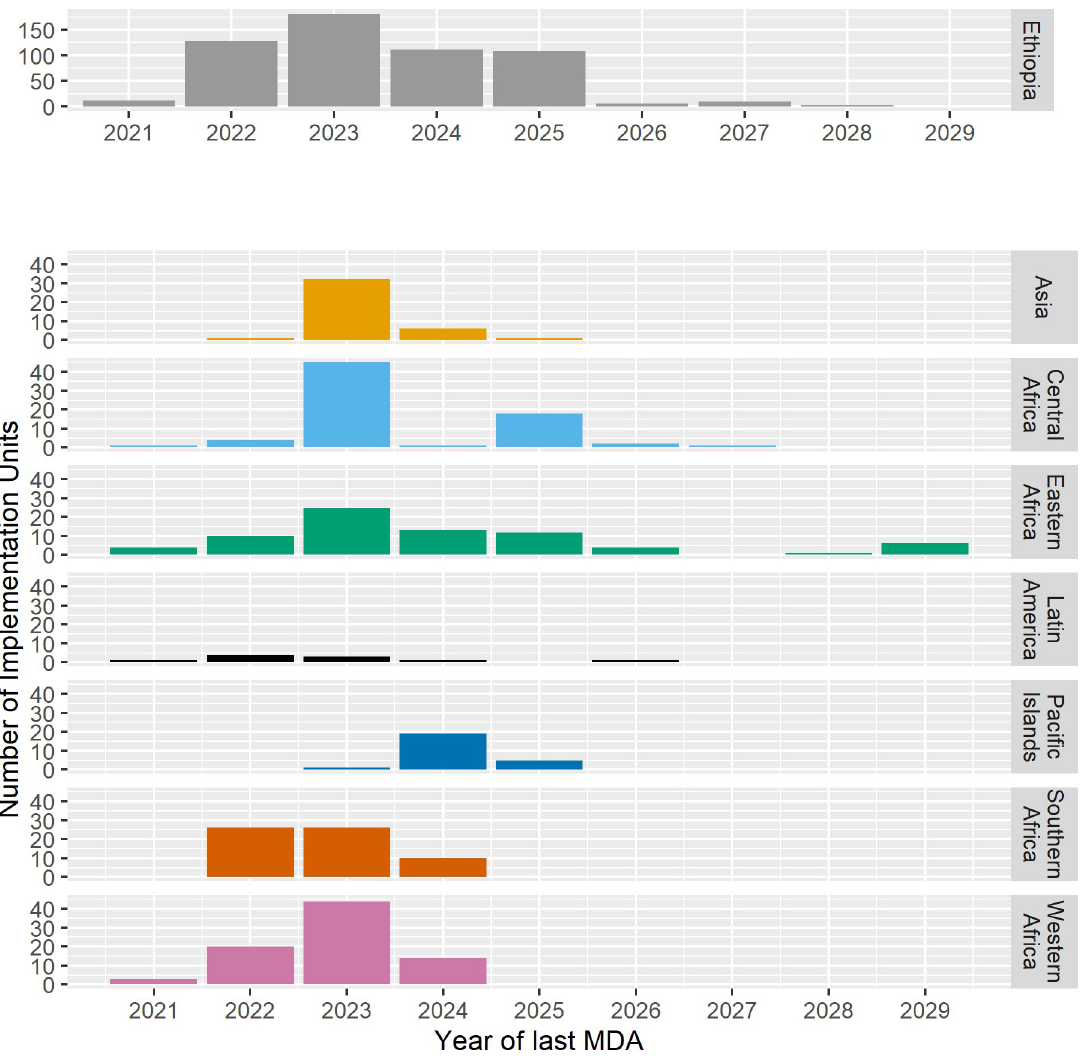
Fig 3. The number of Implementation Units with Mass Drug Administration (MDA) by year of last MDA and geographic group. Note the different vertical axis for Ethiopia compared to the other geographic